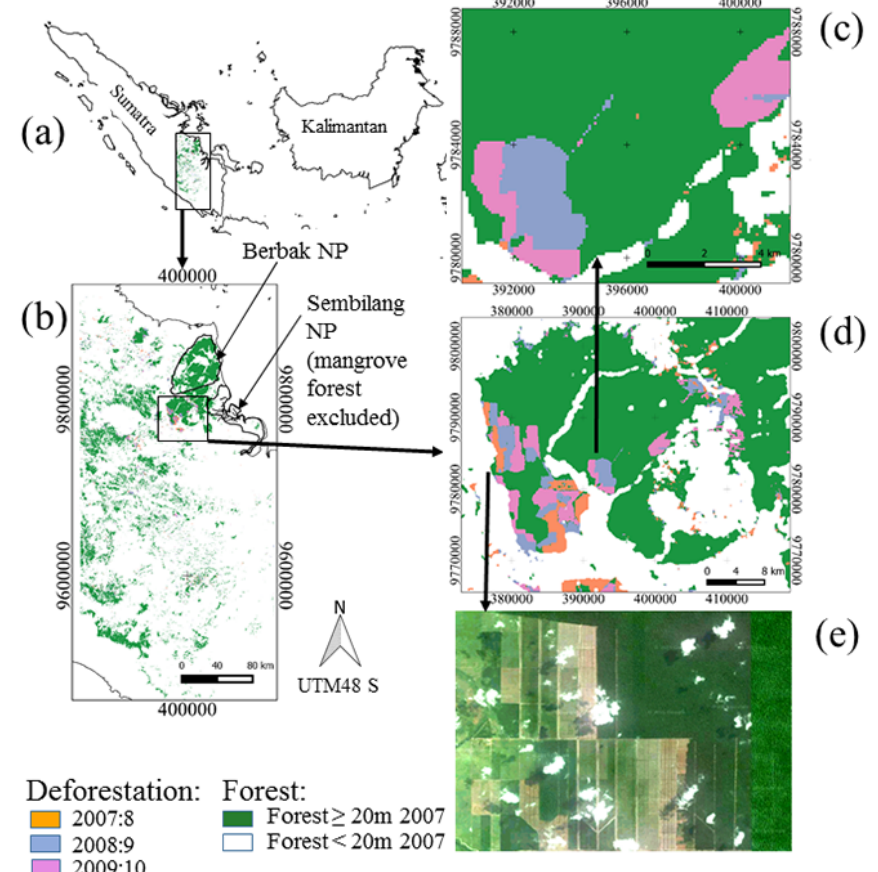
. Figure 4. (a) Location of study area on Sumatra, Indonesia. (b) Study area. Non-forest, mangrove forest, and forest of low height ( < 20m in 2007) in white, which are areas that were excluded from the analysis, and forest in green (height ≥ 20m in 2007). Few large blocks of intact forest remain except Berbak National Park, obvious as an area of dark green in the far north. The large area in the centre of the park burned in the 1996/1997 fires. The “ribbons” of non-forest areas running through the park indicate where we have removed flooded forest. Deforestation after 2007 is orange, blue and pink for each subsequent year. (c) We are able to detect deforestation infrastructure development, here a road/canal connecting different areas of plantation. (d) Demonstrates the annual progression of forest loss in large geometric patterns consistent with forest clearance for roads, canals and plantations. (e) High-resolution Google Earth image from 8 May 2009, providing optical verification of changes detected using SAR. This image may be viewed at full resolution in Google Earth at 1 ◦ 53 (cid:48) 40.71 (cid:48)(cid:48) S, 103 ◦ 52 (cid:48) 56.69 (cid:48)(cid:48) E. The deforestation map is available online in a repository at